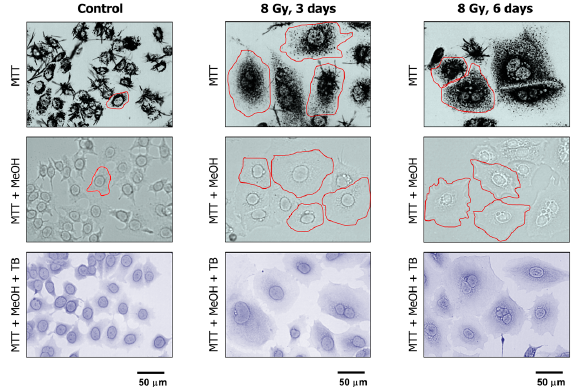
Figure 4. Representative bright-field microscopy images depicting the metabolic activity of MCF7 cultures before (control) and at indicated times after 8-Gy irradiation. Metabolic activity was measured by the ability of the cells to convert the yellow MTT to its purple formazan metabolite, appearing as dark granules and crystals. Upper row: images were acquired after incubation of cells with MTT for ~1 h. Middle row: following incubation with MTT, cells were fixed in methanol for 0.5 min to dissolve the MTT metabolite. The resulting purple medium was removed before acquiring images of cells. Lower row: MTT treated and methanol fixed cells were mildly stained with trypan blue (TB) to visualize their morphology. All images were acquired at the same magnification. The border of some cells is marked for clarity.